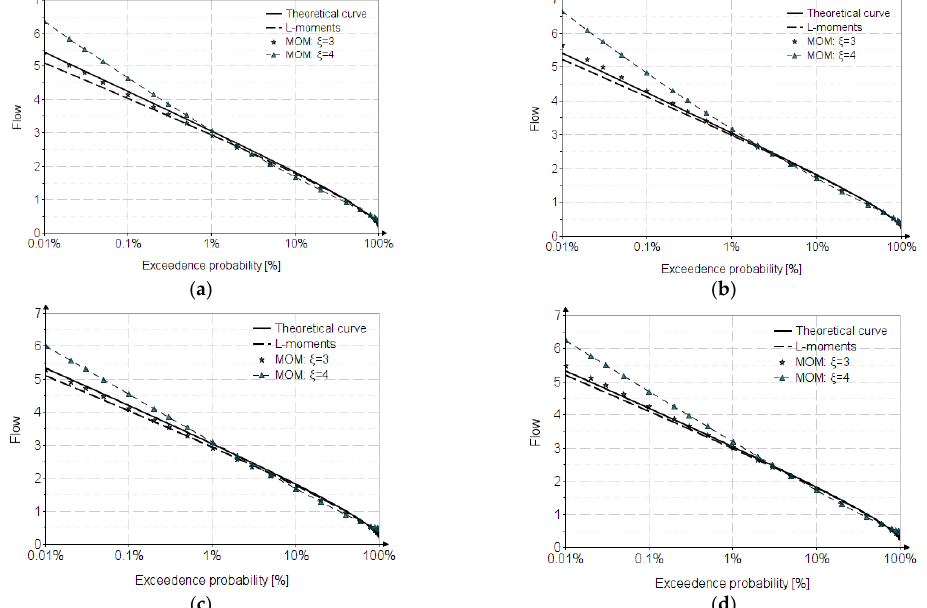
Figure 2. Theoretical and sample curves for PW and PE3. ( a ) Pseudo-Weibull, n = 20; ( b ) Pseudo- Weibull, n = 50; ( c ) Pearson III, n = 20; ( d ) Pearson III, n = 50. The theoretical Pearson III distribution curves applying the INHGA methodology are presented. This methodology involves multiplying the flow with a probability of exceed- ance of 1%, generally calculated with genetic formulas, with transition coefficients of the Pearson III distribution of = v C 1 and = 4 . STAS 4068/1-82 [16] specifies that this may